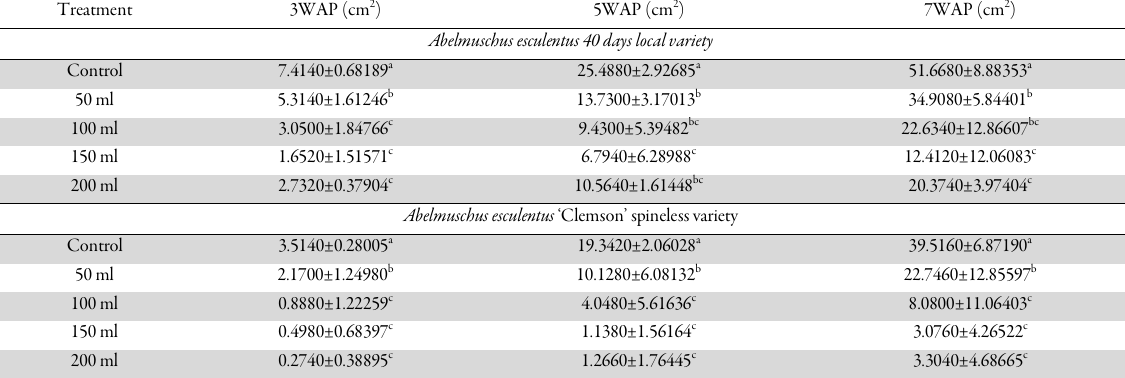
Table 5. Leaf area of plants as affected by different concentrations of spent engine oil